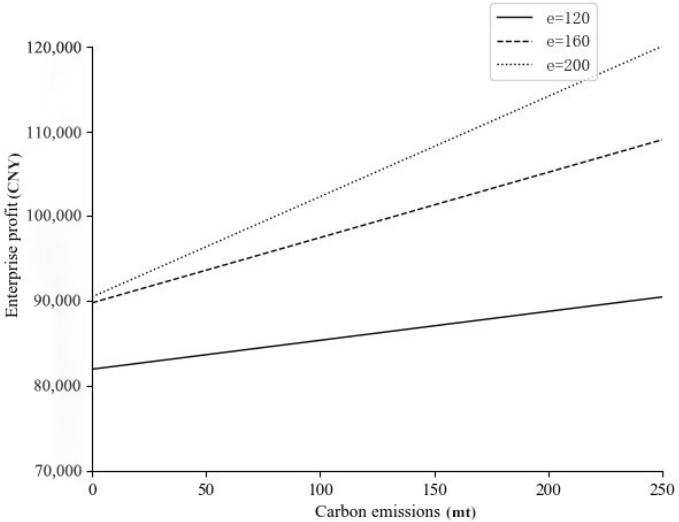
Figure 2. The impact of carbon trading price on enterprise profits.